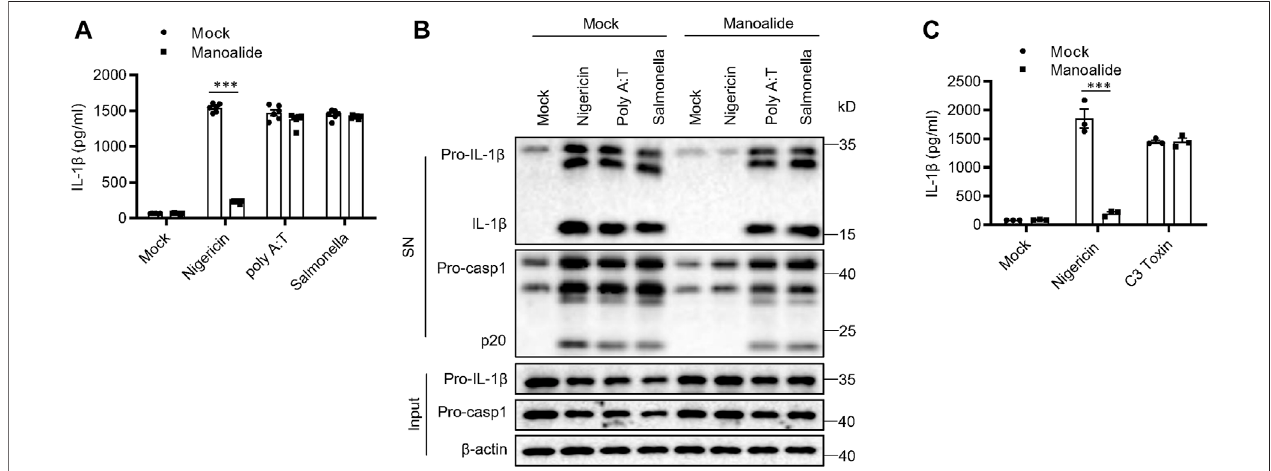
FIGURE 2 | Manoalide has no effects on the activation of AIM2 in fl ammasome, IPAF in fl ammasome or Pyrin in fl ammasome. (A) ELISA of mature IL-1 β and (B) Western blots of SN and Input from BMDMs primed with LPS and stimulated with nigericin, Poly (A:T) or salmonella (MOI = 10) with or without 500 nM manoalide. (C) ELISA of mature IL-1 β in SN from BMDMs primed with LPS and then were pretreated with 500 nM manoalide before stimulation with C3 toxin. Data are derived from three independent experiments (A,C) and displayed as mean and SEM ( n = 6) or represent three independent experiments (B) . Statistically signi fi cant difference was calculated by unpaired Student ’ s t-test: *** p <